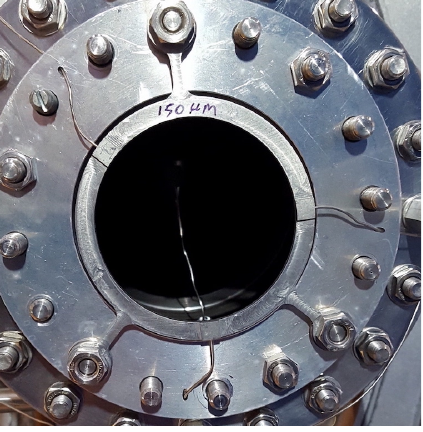
Figure 11. ITER window sensor mounted on MISTRAL port.